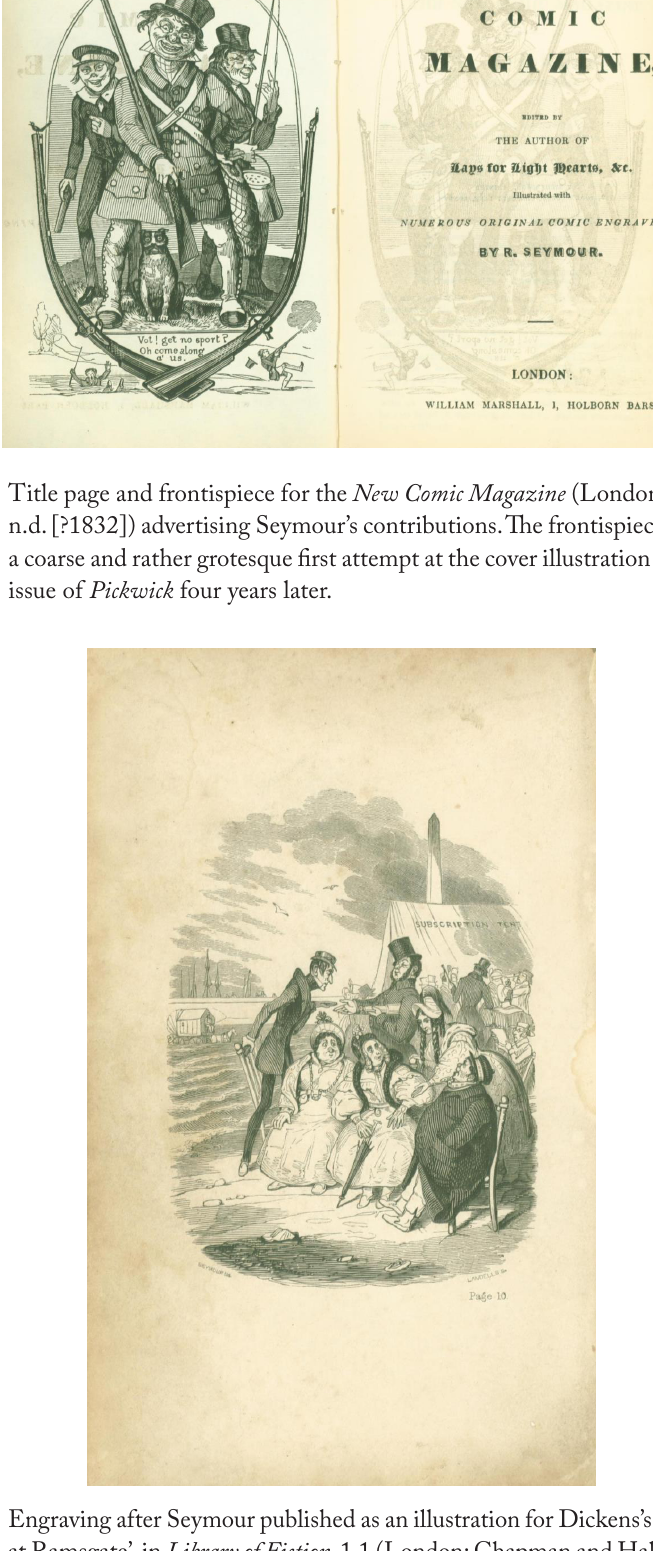
Fig. 5 Engraving after Seymour published as an illustration for Dickens’s ‘The Tugg’s at Ramsgate’, in Library of Fiction , 1.1 (London: Chapman and Hall, 31 March